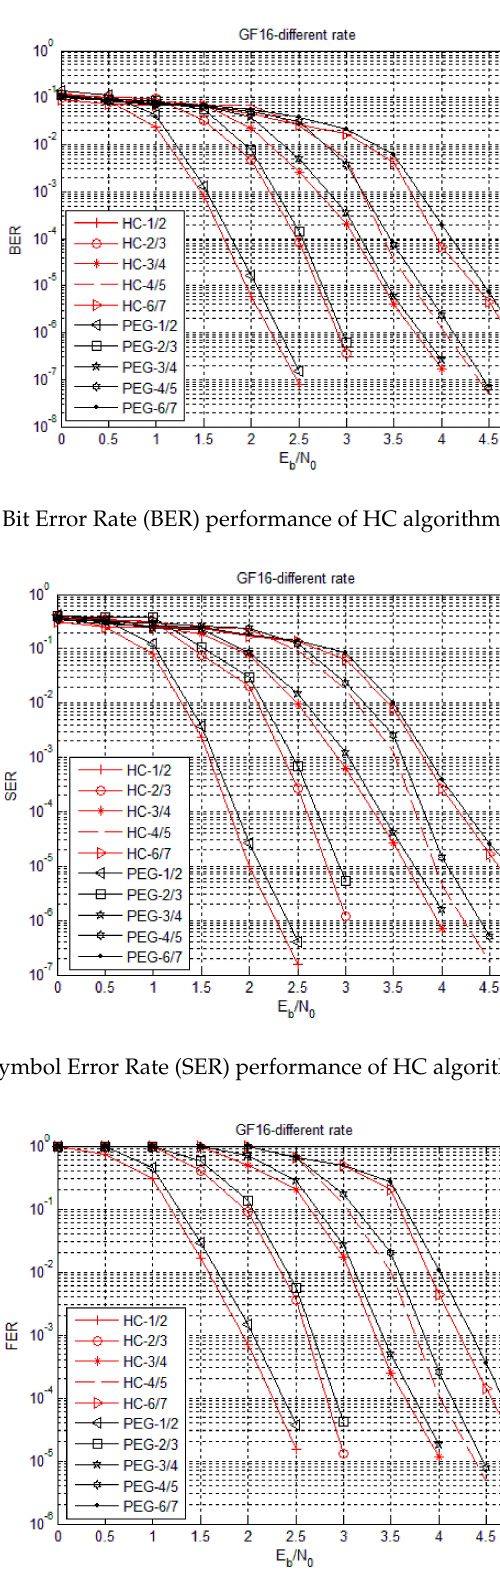
Figure 9. Frame Error Rate (FER) performance of HC algorithm with